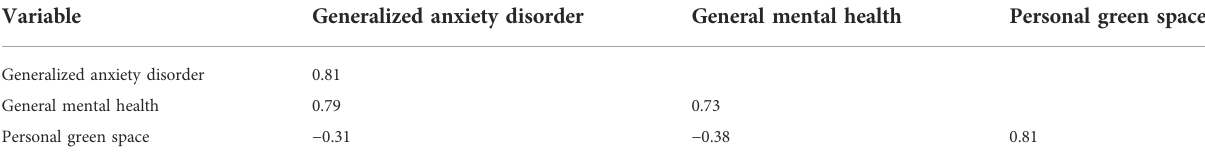
TABLE 2 Divergent validity matrix using Fornell and Larker methods for research variables.